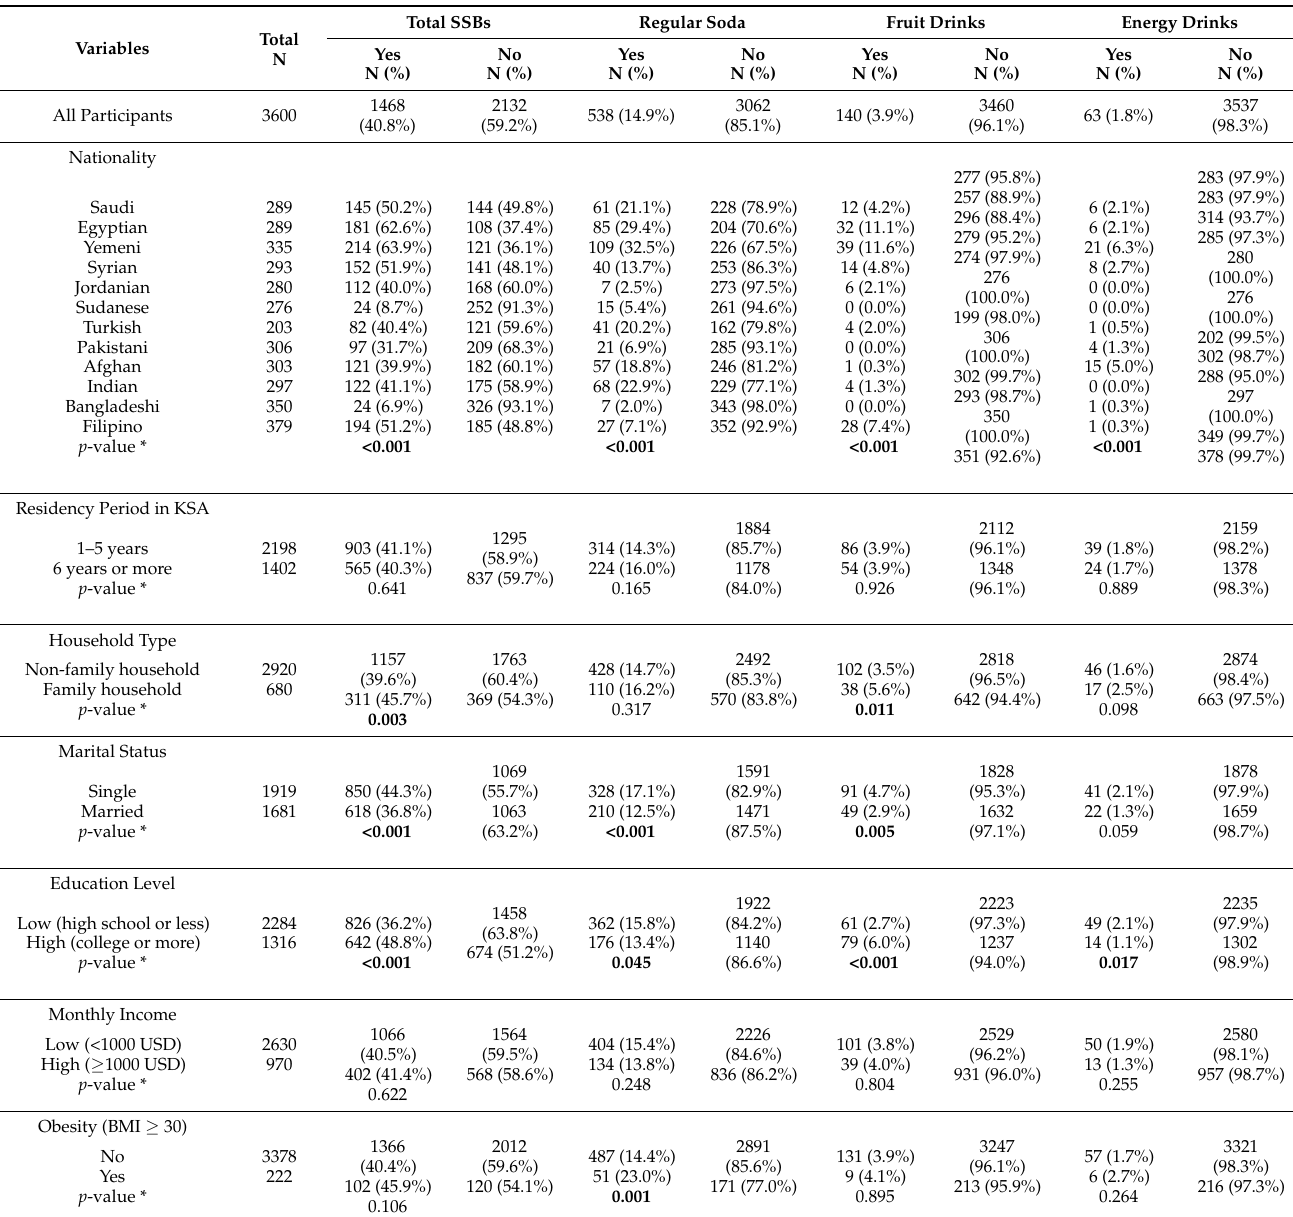
Table 2. Prevalence of daily sugar-sweetened beverage (SSB) consumption among study participants ( n = 3600) stratified by sociodemographic characteristics and